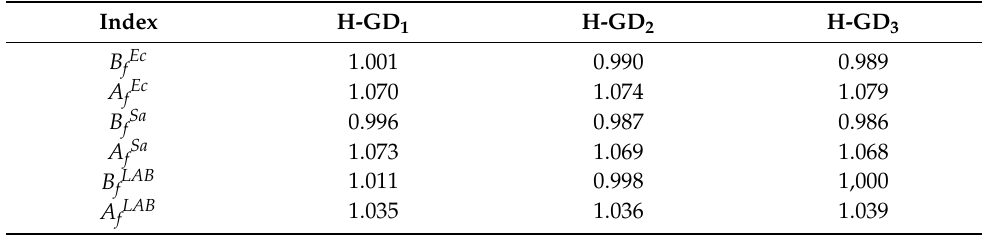
Table 9. Bias and accuracy on the independent data sets of co-culture growth of E. coli (Ec), S. aureus (Sa), and Fresco (LAB) culture in